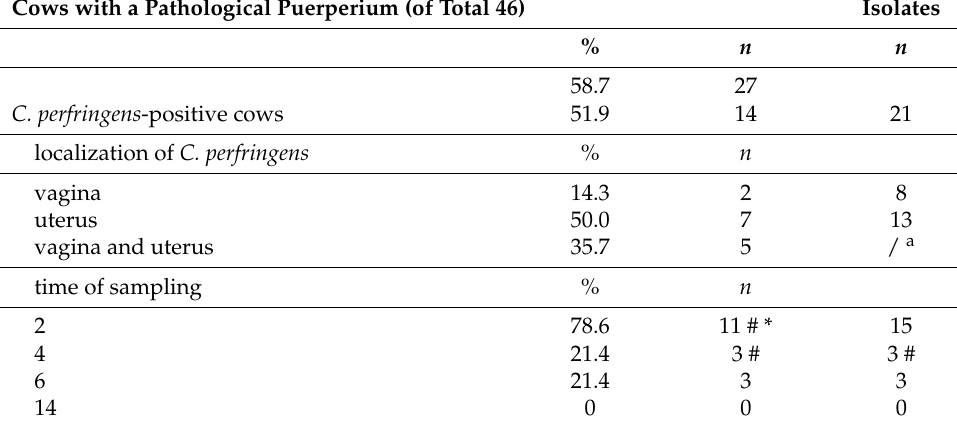
Table 4. Overview of the incidence of C. perfringens positive cows over the sampling period and localization. Cows with a Pathological Puerperium (of Total 46)